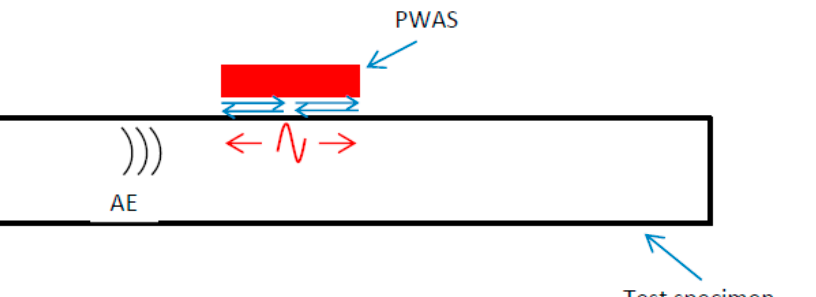
Figure 3. PWAS sensing mechanism. PWAS senses in-plane and out-of-plane wave motions through sensing in-plane strain.